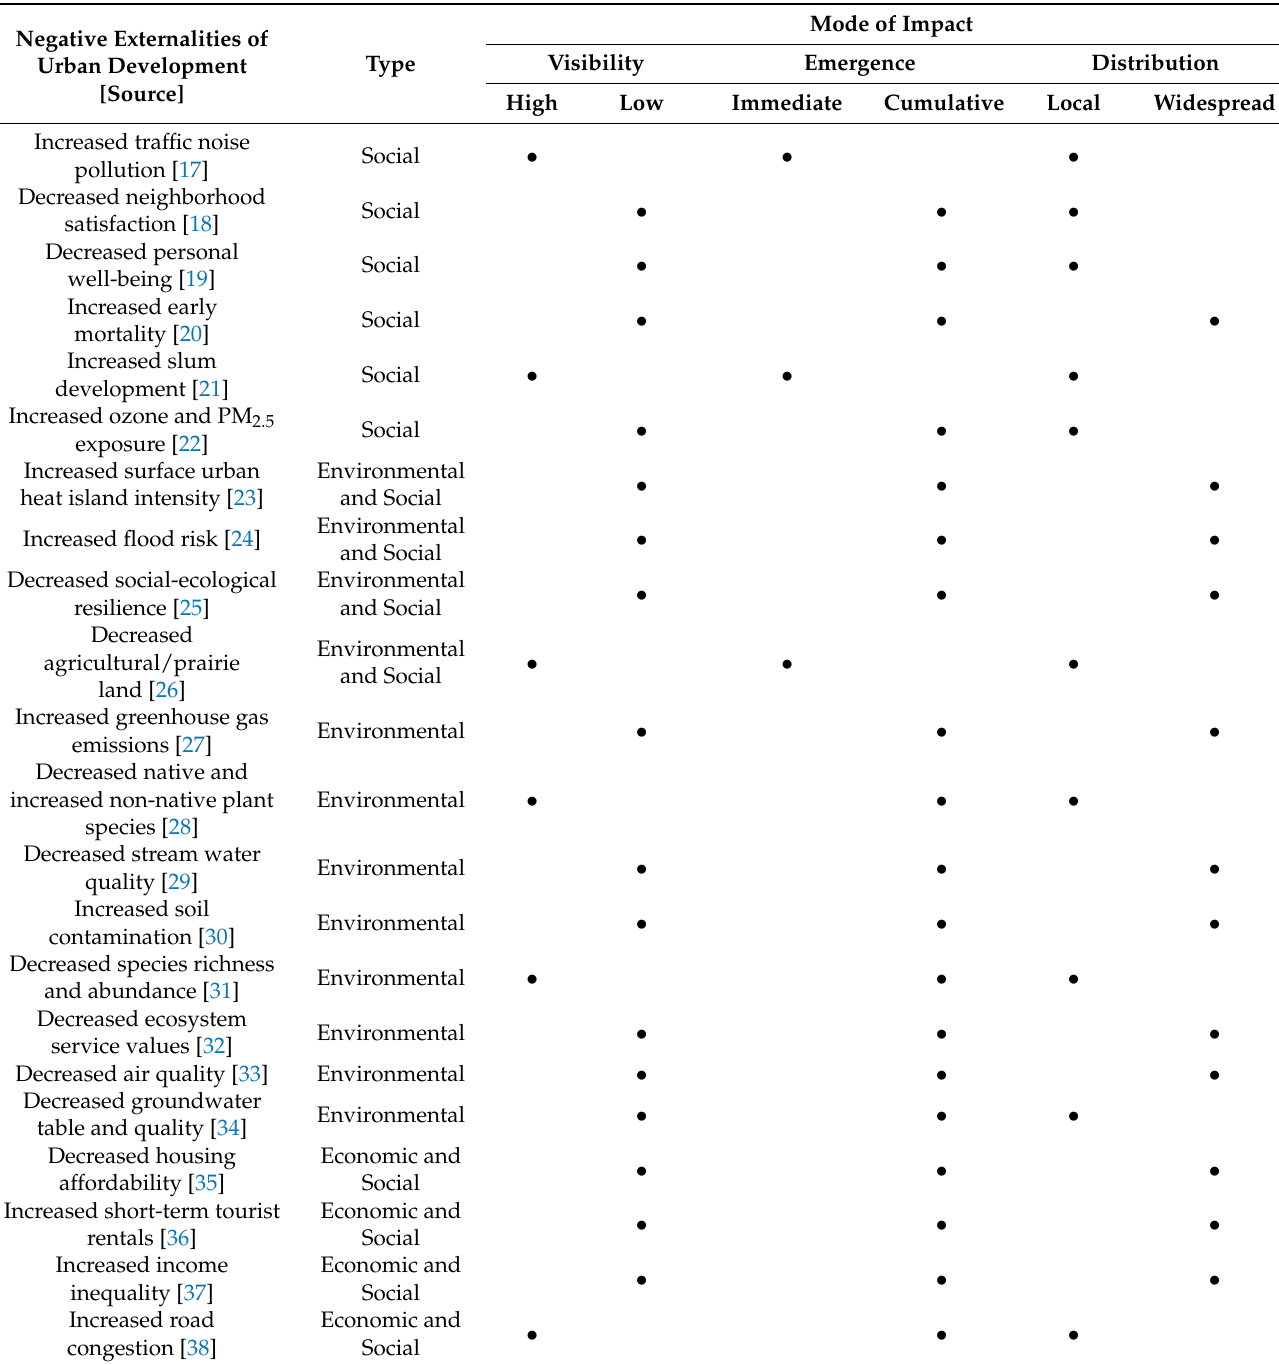
Table 1. Negative Externalities of Urban Development. The table shows the range of negative externalities of urban development, derived from the sample literature, categorized by primary type(s) and mode of impact. Most negative externalities discussed in the sampled articles could be characterized as less visible, cumulative in emergence, and as having widespread